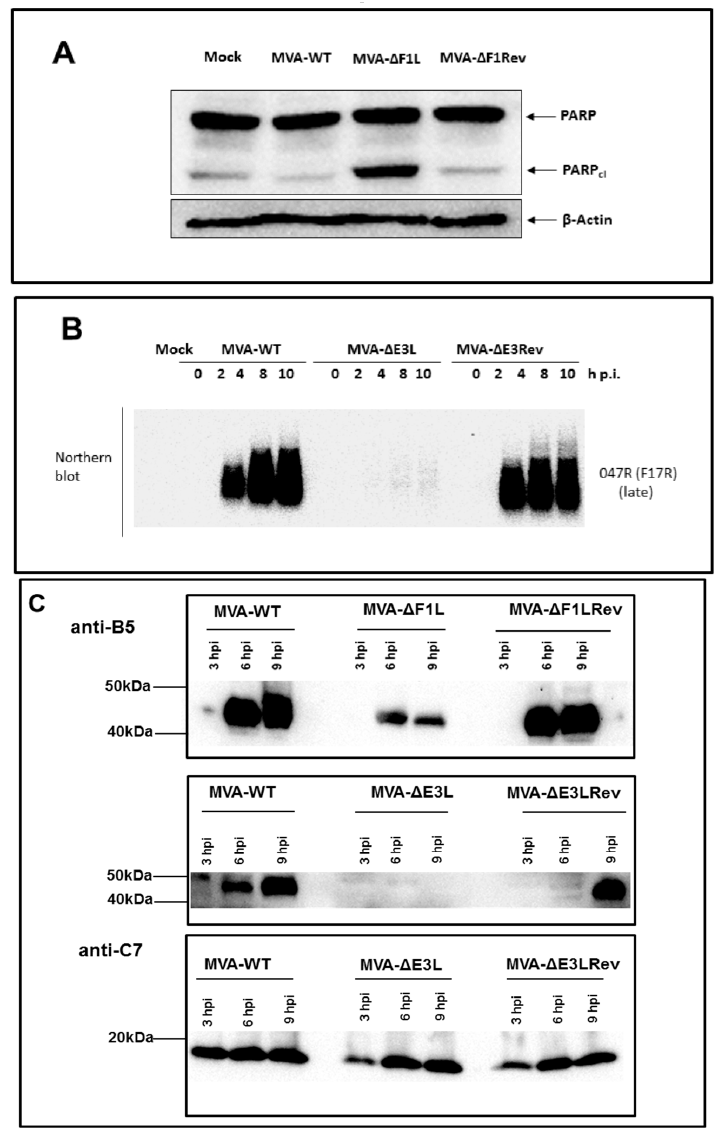
Figure 1. ( A ) Western blot analysis of deletion mutant virus MVA- Δ F1L-induced apoptosis in murine cells. Lysates of NIH/3T3 cells infected with Modified Vaccinia virus Ankara (MVA), MVA- Δ F1L or MVA- Δ F1Lrev at a multiplicity of infection (MOI) of 5 were prepared 15 hpi, proteins were separated by sodium dodecyl sulfate polyacrylamide gel electrophoresis (SDS-PAGE) and immunoblotted against poly-ADP ribose polymerase (PARP)/PARPcl and β -Actin as loading control. ( B ) Inhibition of late gene expression in MVA- Δ E3L infected HeLa cells. Total RNA was isolated and viral late mRNA was monitored by Northern blotting, using riboprobes specific for MVA late gene 047R . ( C ) Western blot analysis of MVA proteins produced in HeLa cells. Lysates of cells infected with deletion mutant viruses MVA- Δ F1L and MVA- Δ E3L were prepared at three, six, or nine hpi. Polypeptides were separated by SDS–PAGE and tested by immunoblotting using specific polyclonal antibodies against vaccinia virus (VACV) B5 protein and VACV C7 protein. Lysates from uninfected cells (Mock) or wildtype MVA infected cells (MVA-WT) or revertant viruses (MVA- Δ F1Lrev, MVA- Δ E3Lrev) infected cells served as controls. Indicated on the left are the positions of the molecular weight markers in comparison to the ~45 kDa VACV B5 (B5) and ~17 kDa VACV C7 (C7) proteins.